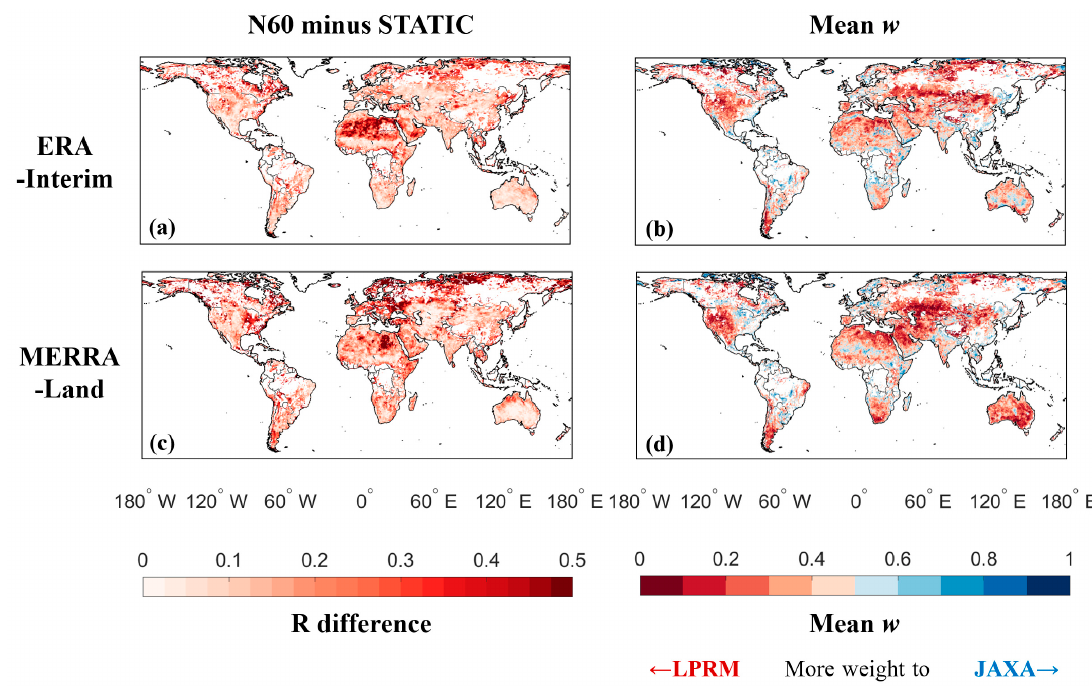
Figure 4. Comparison between combined soil moisture products. For ERA-Interim as the reference, ( a ) The differences in R between the static and N60 products against the reference ( i.e ., R of N60 minus R of static) and ( b ) the mean weights that were used for the dynamic combination using the reference over the two-year study period; ( c ) and ( d ) show corresponding results with ( a ) and ( b ) when using MERRA-Land as the reference.